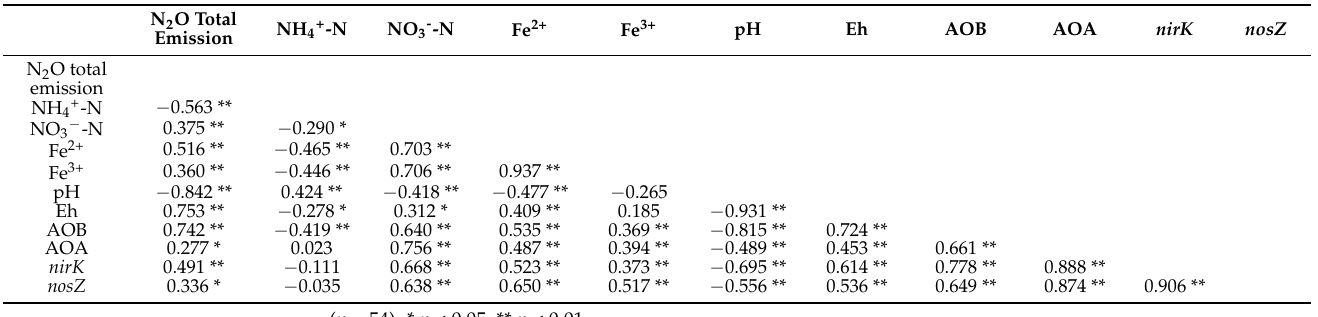
Table 3. Correlation between N 2 O and measured environmental factors in the two paddy soils.